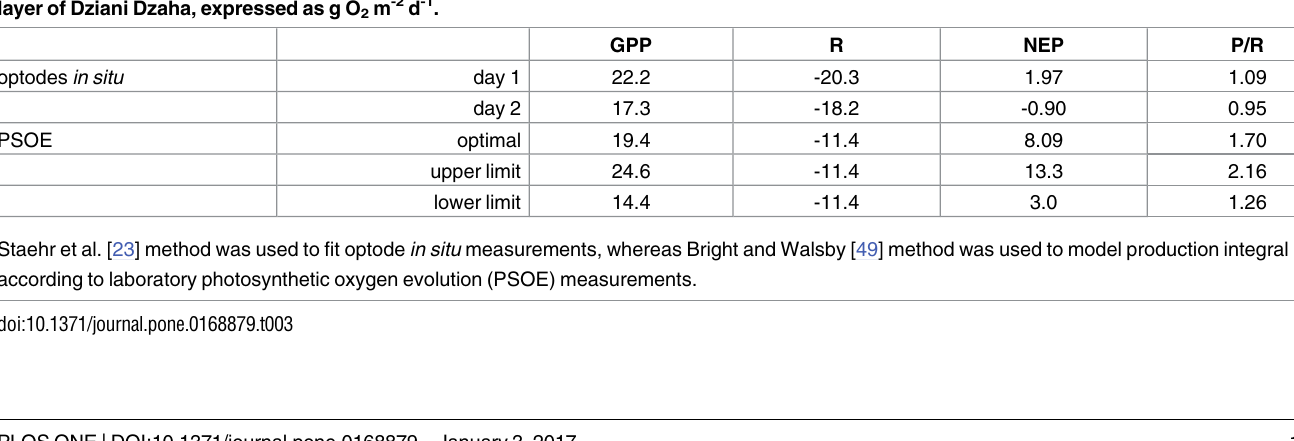
Table 3. Estimate of daily gross primary production (GPP), respiration (R) and net ecosystem production (NEP) integrated over the upper photic layer of Dziani Dzaha, expressedas g O 2 m -2 d -1 .